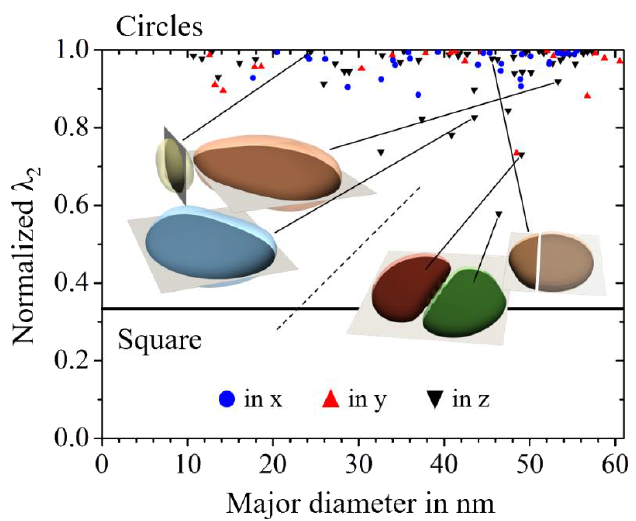
Figure 11. Study on the impact of the particle–particle interaction on the in-plane shape of tetragonally misfitting particles. Plot of the normalized λ 2 values as a function of the major diameter for the selected data subset from the large-scale 3D simulation study of θ′ precipitation in Al-Cu alloys [49].